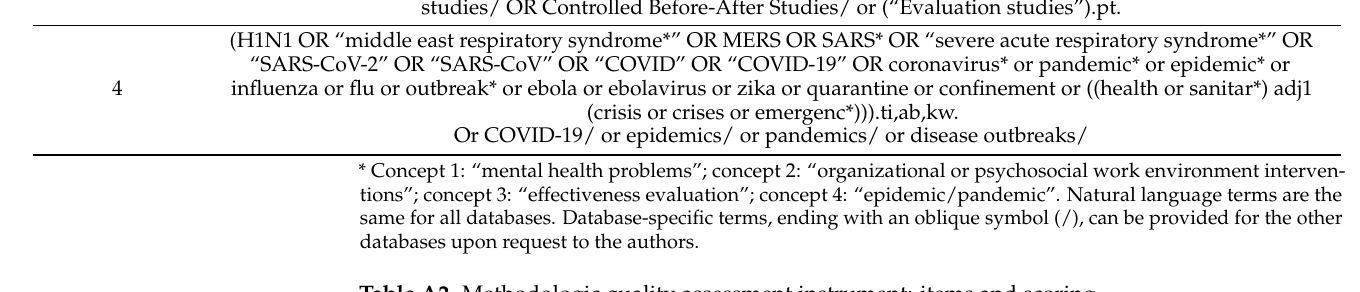
Table A2. Methodologic quality assessment instrument: items and